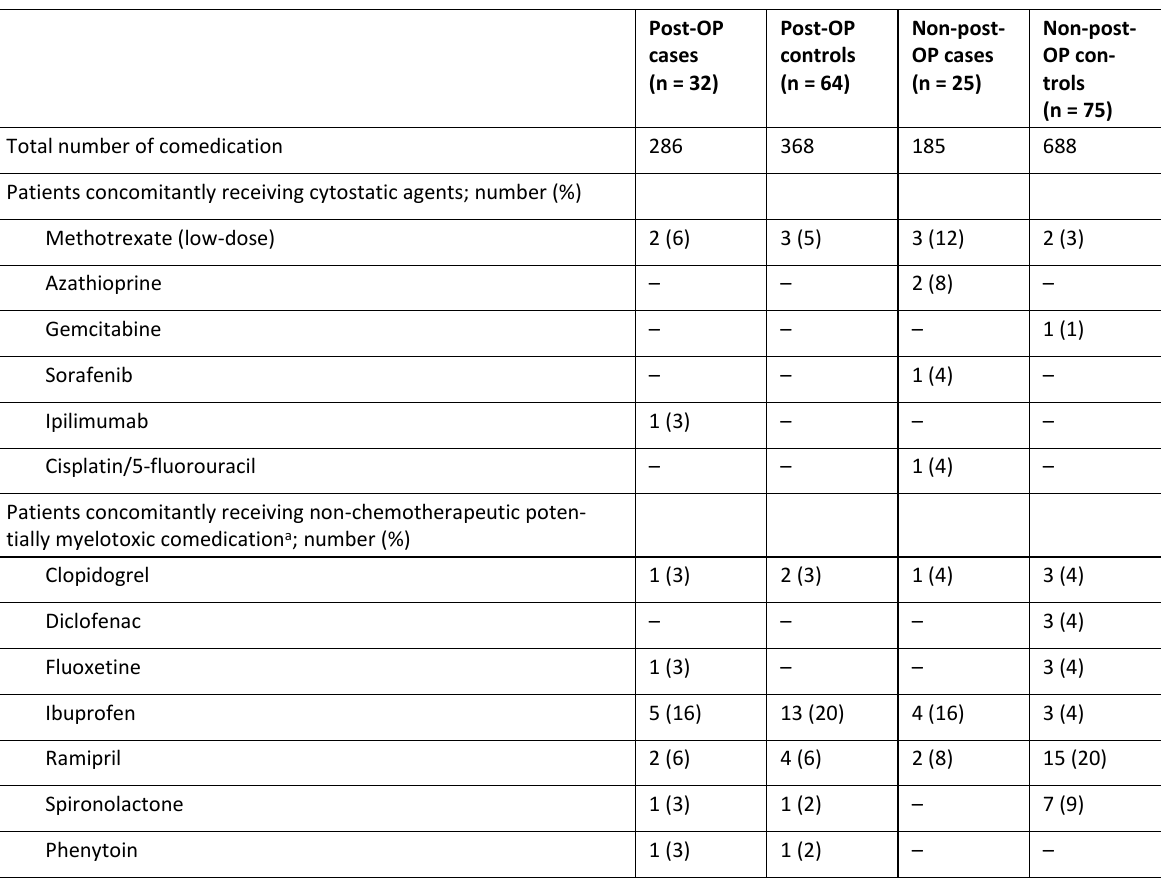
Table 5: Comedication known to be associated with